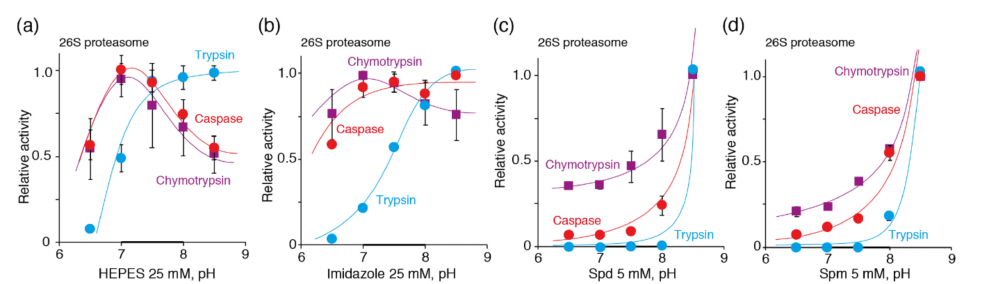
Figure 3. The pH dependence of the proteasomal chymotrypsin-like (violet), trypsin-like (blue), and caspase-like (red) peptidase activities in the bu ff ers containing HEPES ( a ), imidazole ( b ), spermidine ( c ), and spermine ( d ). Activity of the 26S proteasome was measured using Suc-LLVY-AMC (chymotrypsin-like), Ac-RLR-AMC (trypsin-like) or Ac-GPLD-AMC (caspase-like) fluorogenic substrates at 25 mM of the HEPES and imidazole bu ff er systems and 5 mM of the spermidine and spermine bu ff er systems. Relative activity was calculated as the ratio of activity at a distinct pH to the maximal activity within the tested pH range. The data represent the average and standard deviation (error bars) from four independent measurements. The data were fitted to a polynomial square of an exponential or Gauss function. The physiologically relevant pH range is shown by a bold